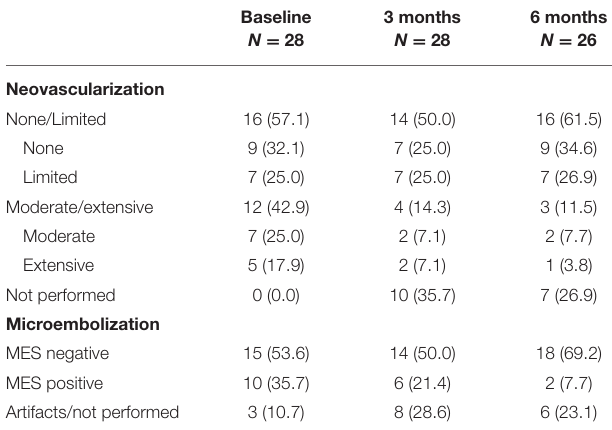
TABLE 2 | Plaque characteristics at baseline. TABLE 3 | Neovascularization and microembolization during follow-up.